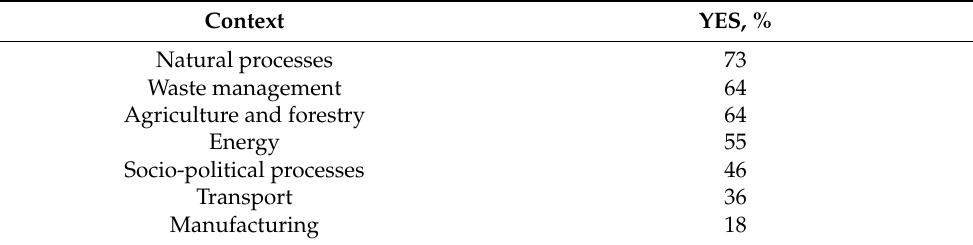
Table 5. Climate change context in parties’ pre-election programmes.